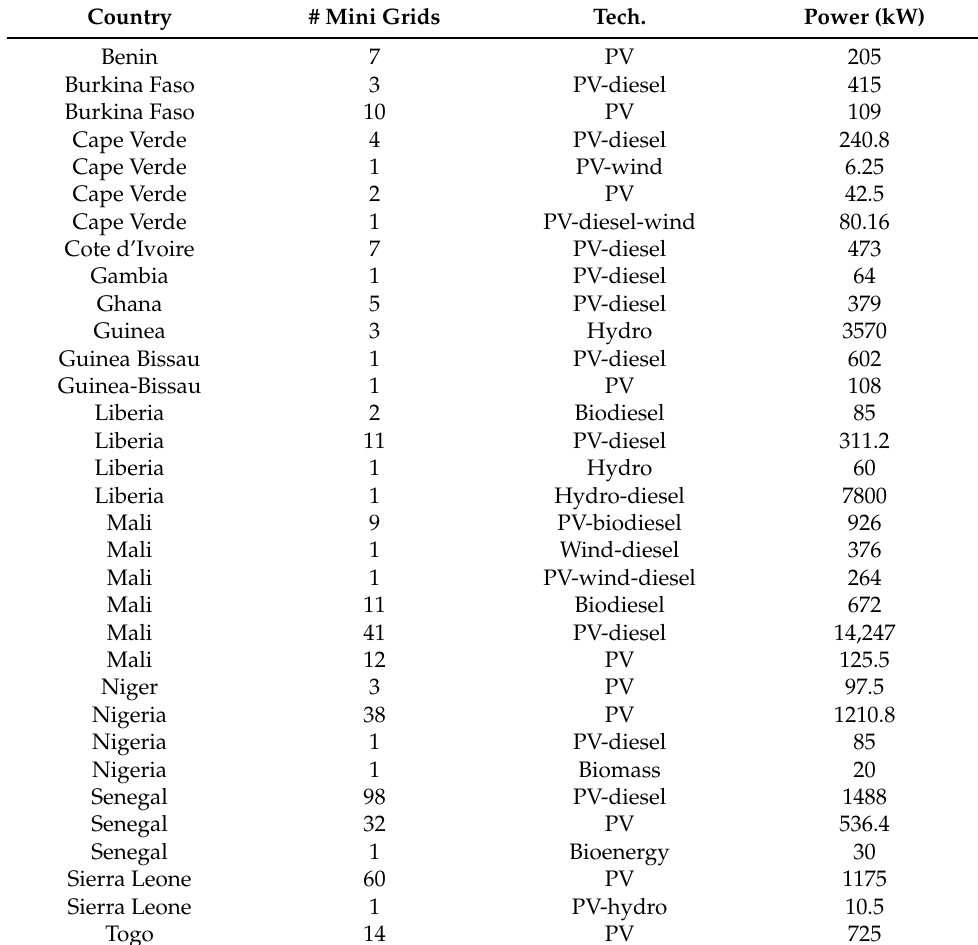
Table 2. State-of-the-art of mini-grid installations in West Africa updated to 2020. Data reproduced with permission from the work in